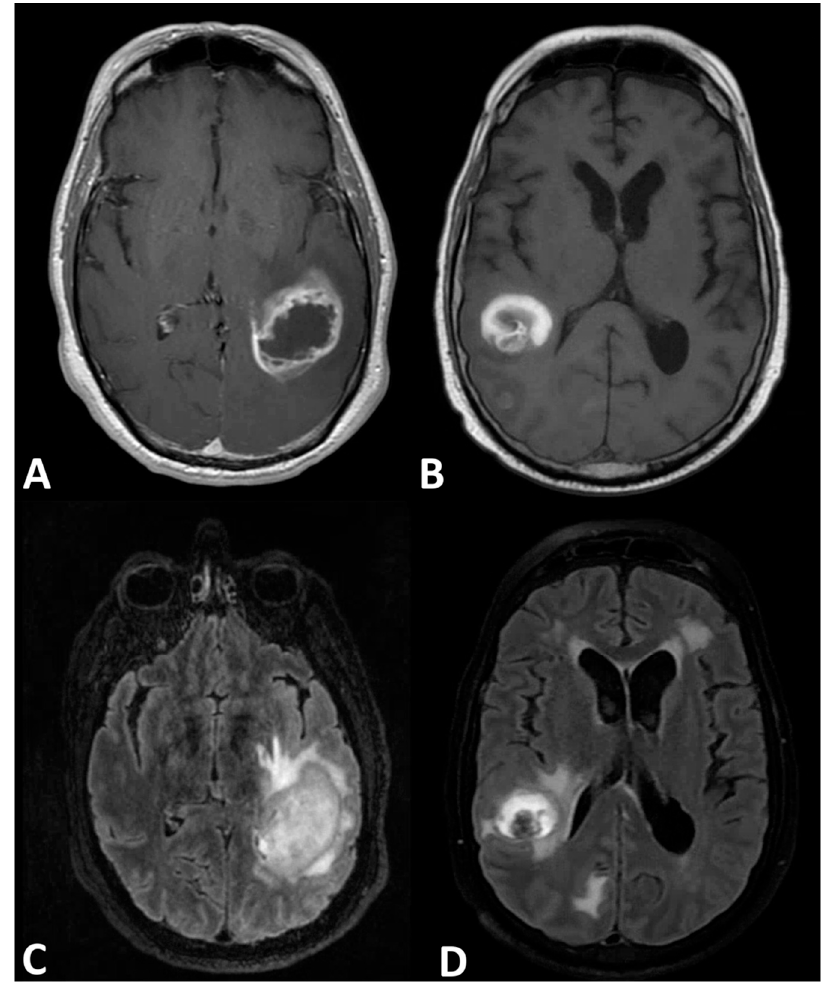
Figure 1. Magnetic resonance imaging. T1 imaging of a left temporal–parietal ( A ) glioblastoma and a left temporal–parietal ( B ) solitary intracranial metastasis both exhibiting ring-enhancing hyperintensity features with peritumoral hypointensity. T2 imaging of ( C ) a glioblastoma and a ( D ) solitary metastasis both characterized by peritumoral hyperintensity.